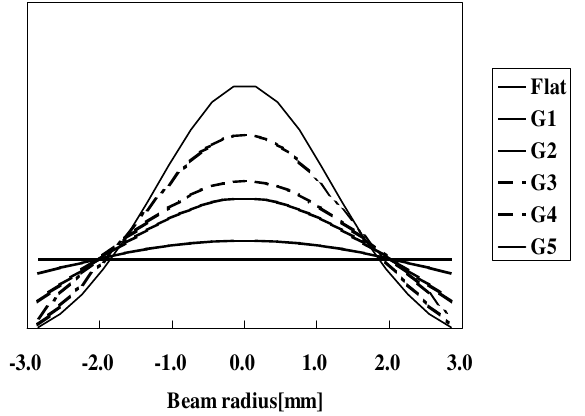
FIG. 12. The Gaussian distribution. The standard deviation (cid:9) of the Gaussian distribution is defined as follows. G1: (cid:9) (cid:6) ; G2: (cid:9) (cid:6) 1 : 00 R 1 : 20 R beam ; G5: (cid:9) (cid:6) 0 : 50 R 0 : 55 R beam